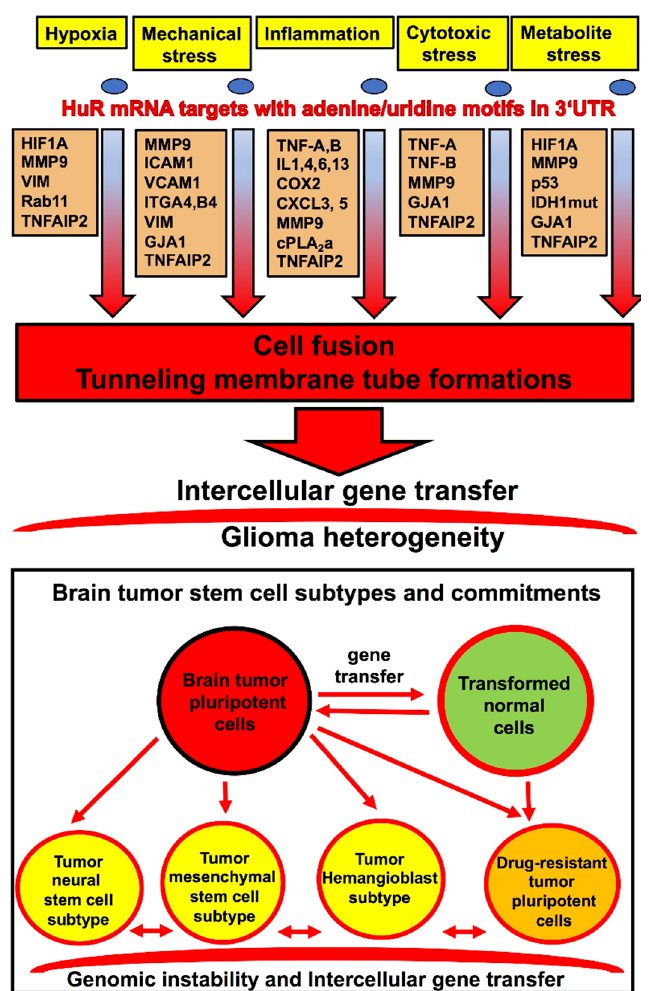
Figure 3. Schematic illustration of HuR-dependent stress response cell-signaling pathways involved in cell fusion and tunneling nanotube formations leading to glioma plasticity and heterogeneity. The proinflammatory cytokines, including IL-1, IL-6, and TNF-alpha, increase the probabilities of lipid protrusions, essential for the cell-to-cell fusion, through the regulation of arachidonic acid